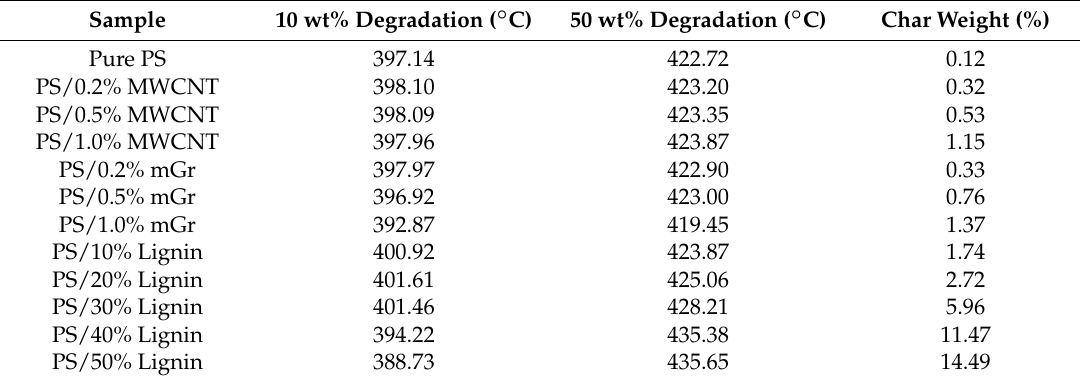
Table 1. The decomposition temperature of PS composite foams.